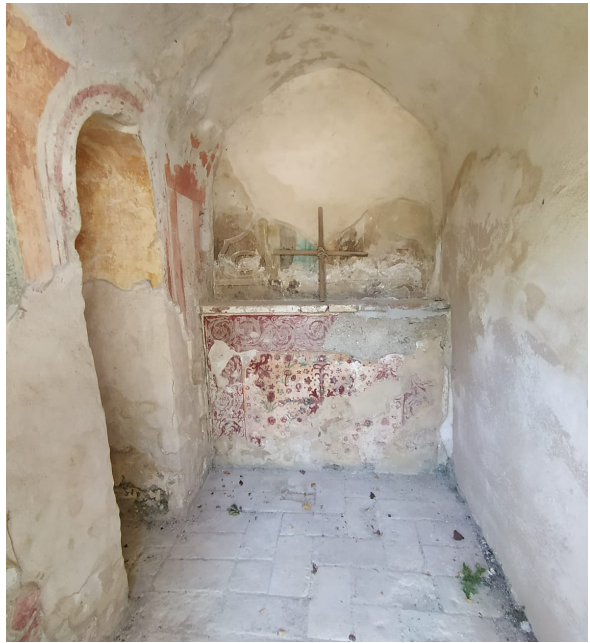
Figure 1 . The inside of one hermitage with its